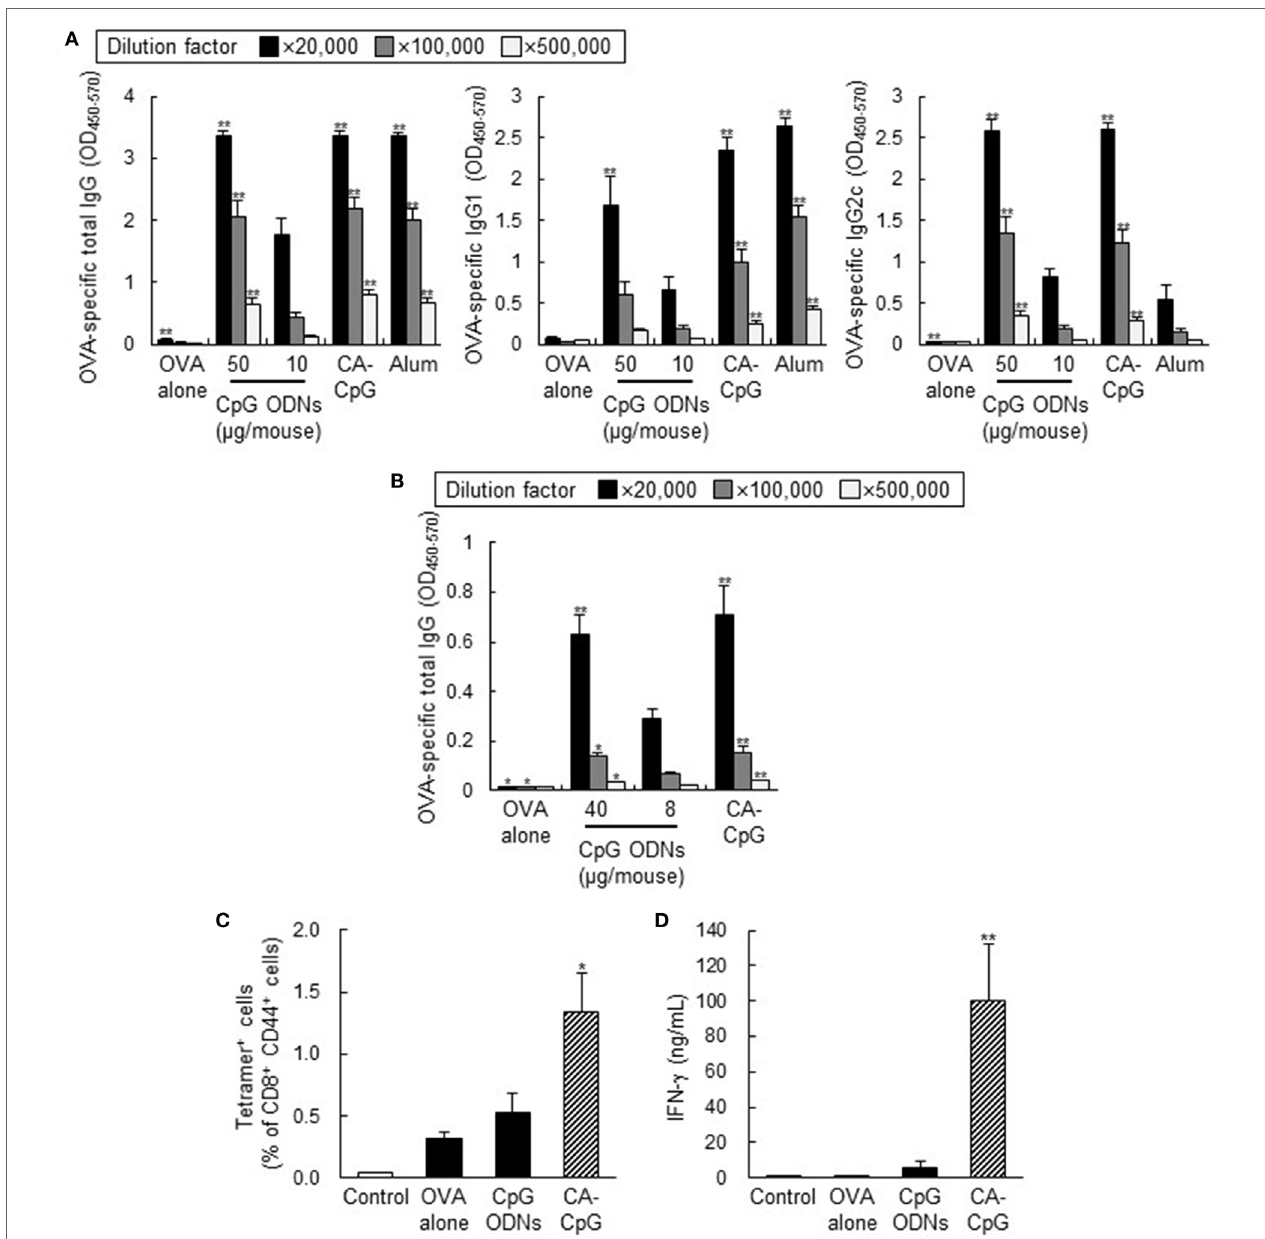
FigUre 5 | Adjuvant effects of carbonate apatite (CA)-cytosine-phosphate-guanine (CpG) in mice. Mice were immunized subcutaneously at the base of the tail (a) or into the ear pinna (B–D) with ovalbumin (OVA) plus CA-CpG at 10 µg CpG oligodeoxynucleotides (ODNs)/mouse (a) or 8 µg CpG ODNs/mouse (B–D) ; with OVA plus K-type CpG ODNs at 10 or 50 µg CpG ODNs/mouse (a) , at 8 or 40 µg CpG ODNs/mouse (B) , or at 8 µg CpG ODNs/mouse (c,D) ; or with OVA plus alum. (a,B) OVA-specific antibody responses. Levels of OVA-specific total IgG, IgG1, and IgG2c in plasma were evaluated by ELISA 7 days after the final immunization, n = 5 per group. (c,D) CD8 + cytotoxic T lymphocyte (CTL) responses. OVA 257–264 -specific CD8 + CTL responses were monitored by means of a tetramer assay in untreated mice and in mice immunized with OVA alone, with OVA plus K-type CpG ODNs, or with CA-CpG (c) , n = 5 per